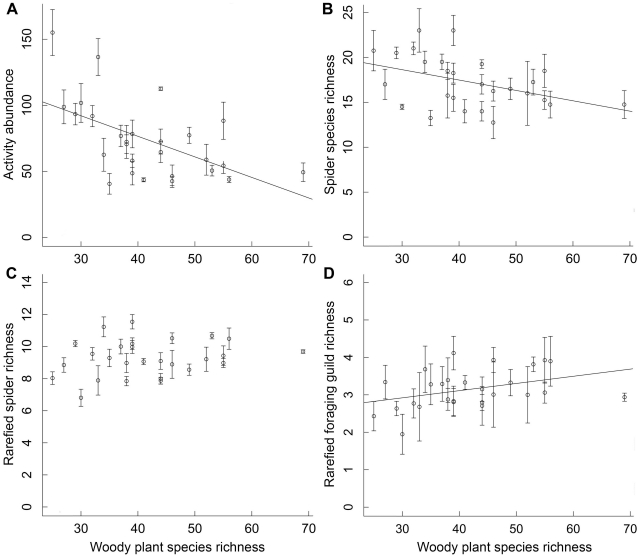
Relationships between species richness of woody plants and spiders.(A) activity abundance, (B) original species richness, (C) rarefied species richness, and (D) rarefied foraging guild richness of epigeic spiders (trap means ± SE for each plot) across a plant species diversity gradient of 27 study plots in subtropical China. Regression lines show significant relationships at P<0.05.